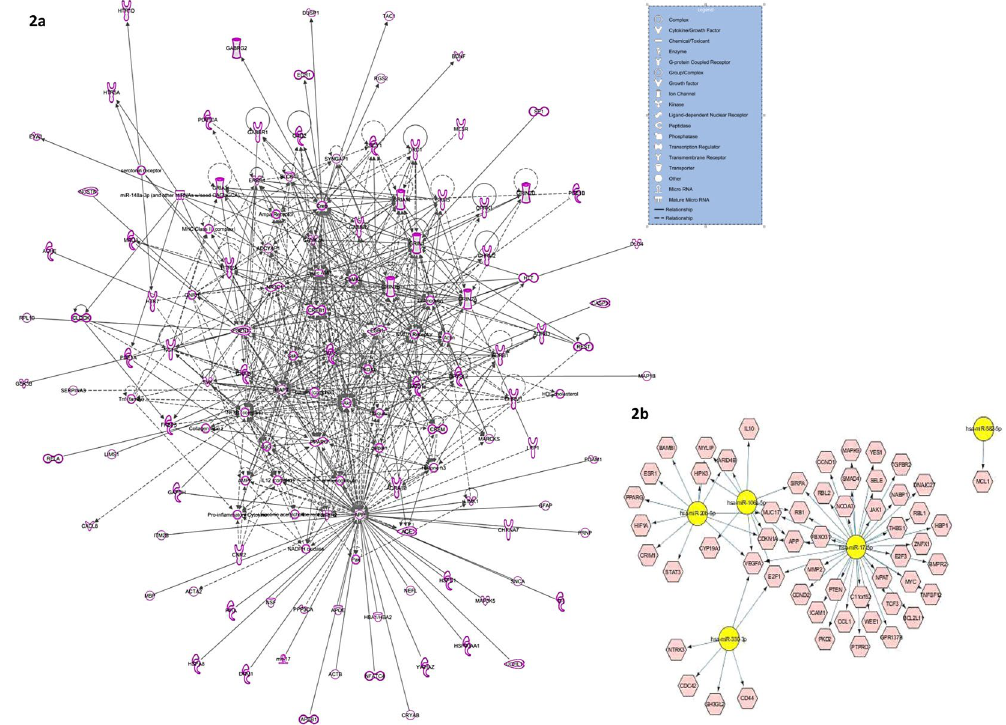
Figure 2. Integrated target gene network based on functional clustering of differentially regulated miRNAs. ( a ) The intense molecular crosstalk (represented as solid lines for direct relationship) is indicative of target enrichment of the differentially regulated miRNAs as found in MDD-suicide group compared to healthy control subjects. In the functional molecular network analysis, shapes of individual molecules are representative of their function and genes are represented as nodes. ( b ) Gene regulatory network of significantly upregulated miRNAs based on validated targets. Using CyTargetLinker plugin from Cytoscape software (version 3.0), functional gene network was constructed based on validated targets of upregulated miRNAs from MDD-suicide